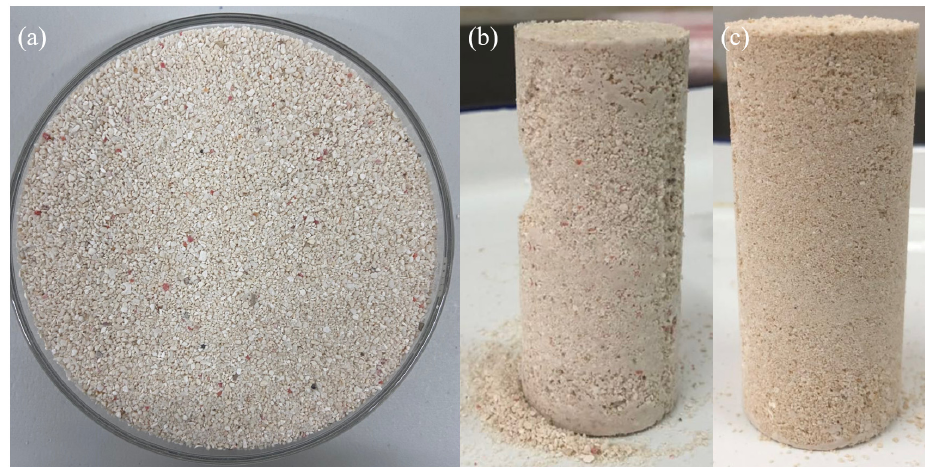
Figure 8. Comparison of calcareous sand before and after biomineralization: ( a ) untreated calcareous sand; ( b ) and ( c ) calcareous sand columns formed by Groups C2 and C4, respectively.